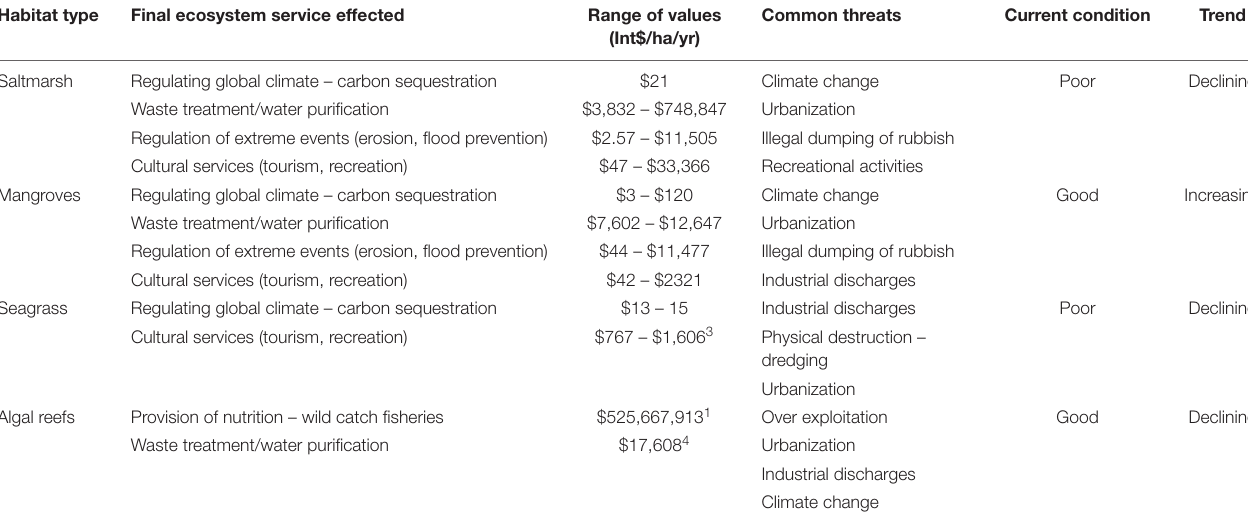
TABLE 2 | Summary of temperate Australian coastal and marine habitats, the major services provided, range of habitat specific published valuations, threats and